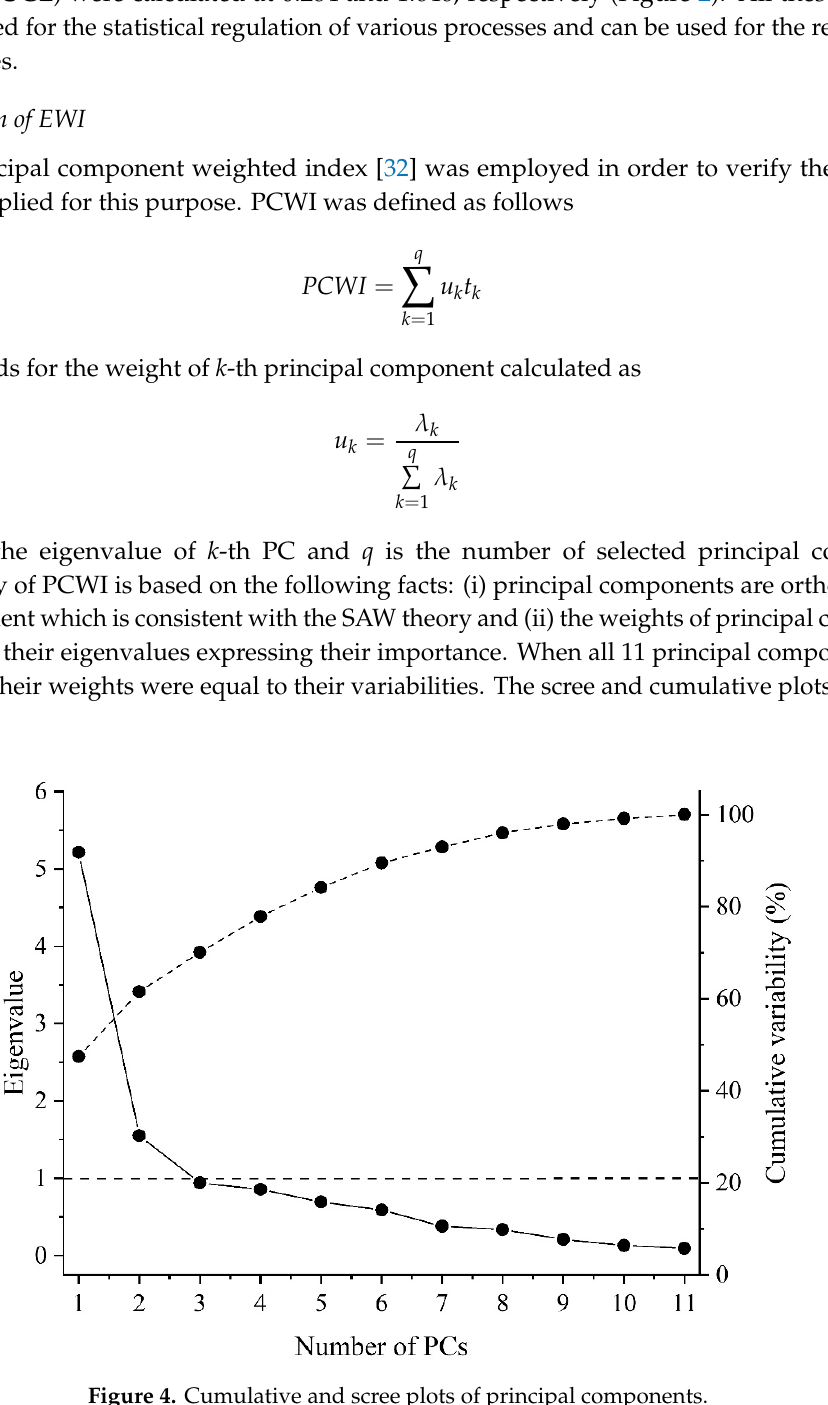
Figure 4. Cumulative and scree plots of principal components.